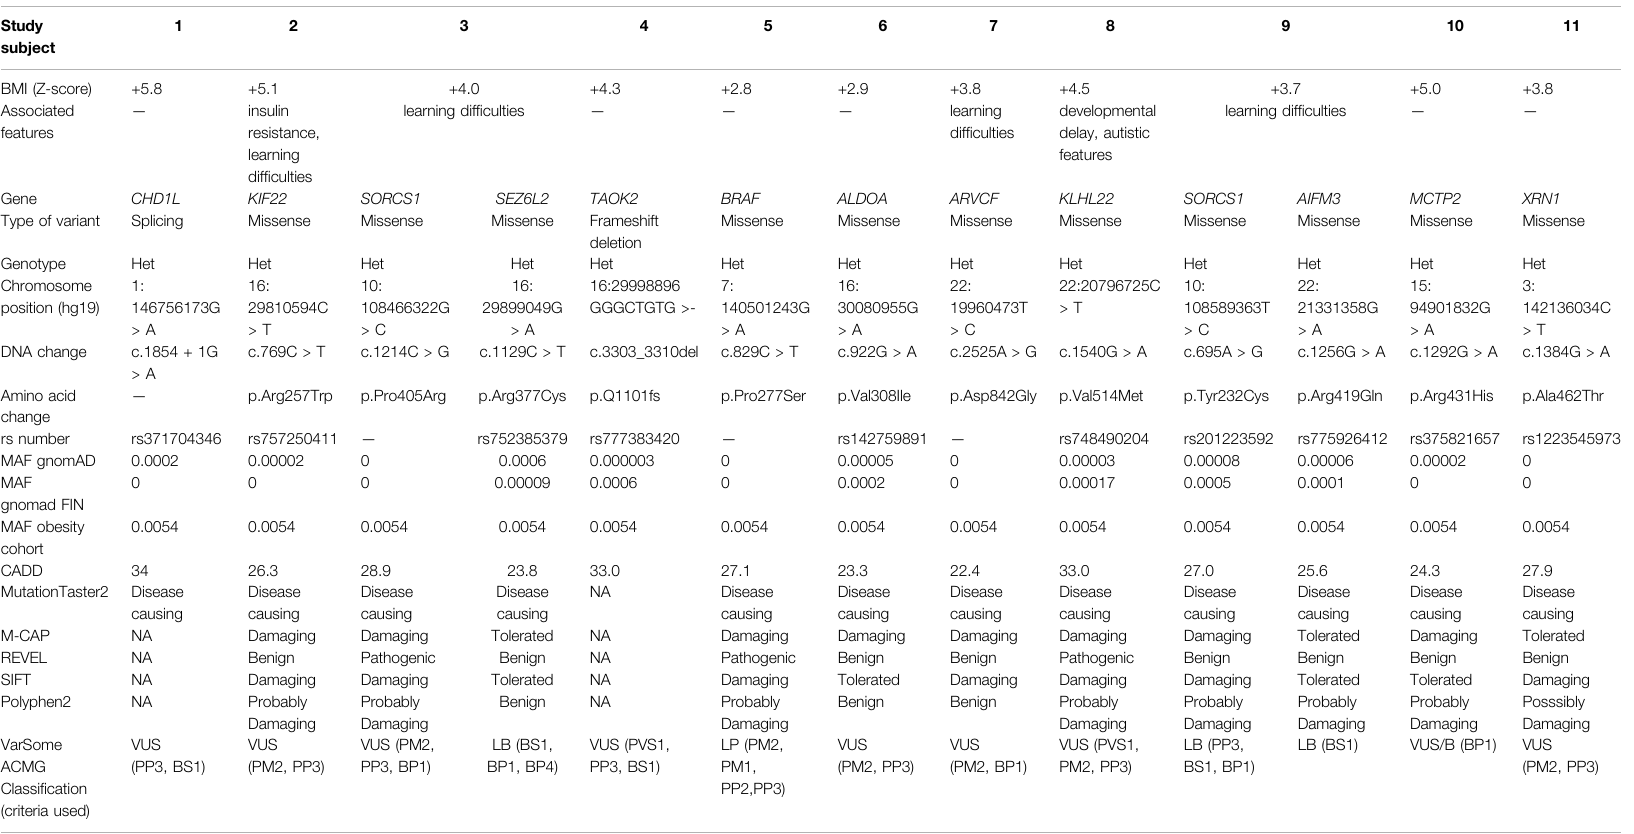
TABLE 1 | The identi fi ed rare variants with minor allele frequencies (MAF) in gnomAD and in silico prediction